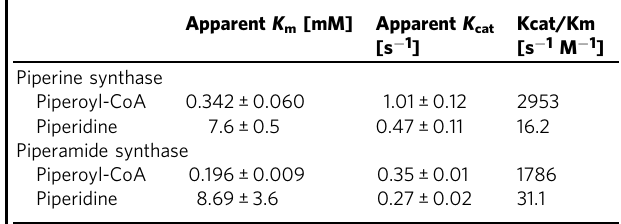
Table 1 Apparent kinetic constants of piperine synthase and piperamide synthase using piperoyl-CoA (5 – 2000 µ M) and piperidine (1 – 100 mM) as substrates.